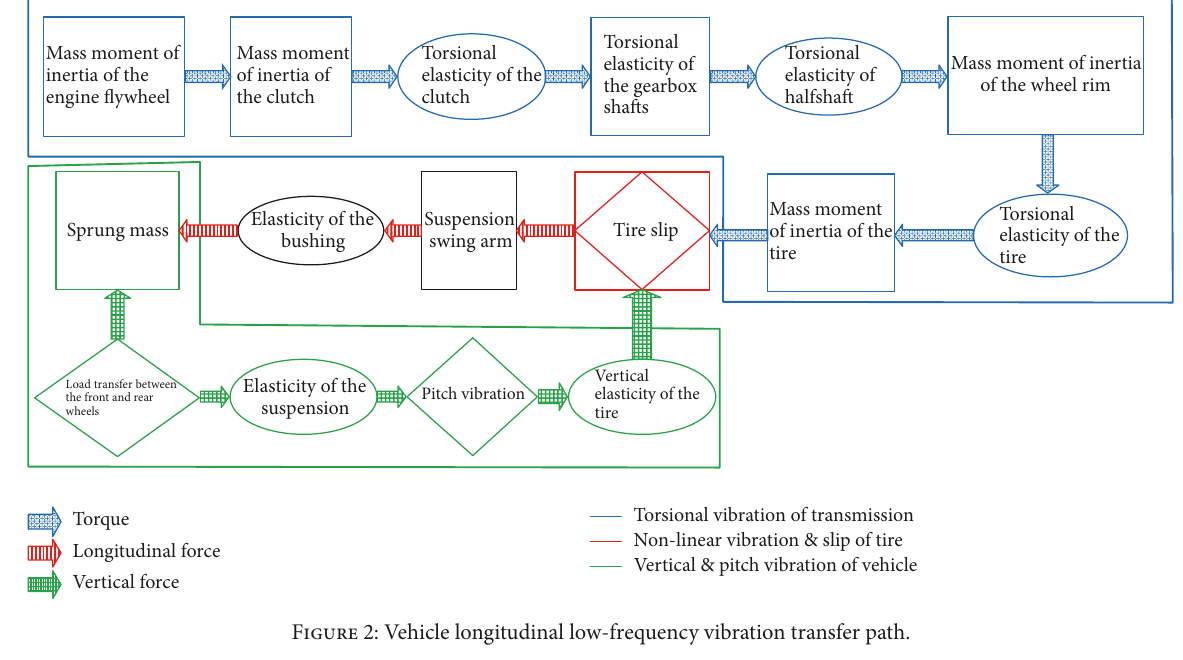
Figure 2: Vehicle longitudinal low-frequency vibration transfer path.